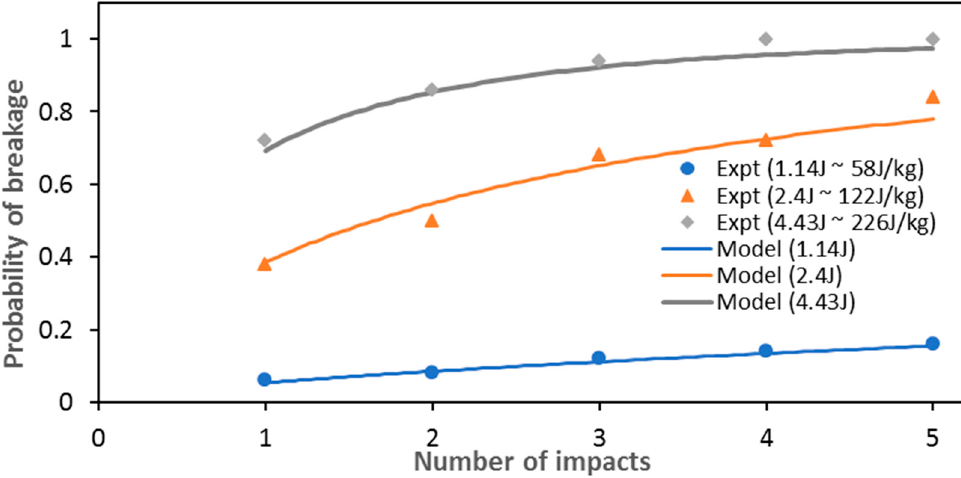
Figure 8. Experimental and Model Breakage probability curves for a − 26.5 + 22.4 mm Dolomite sample.